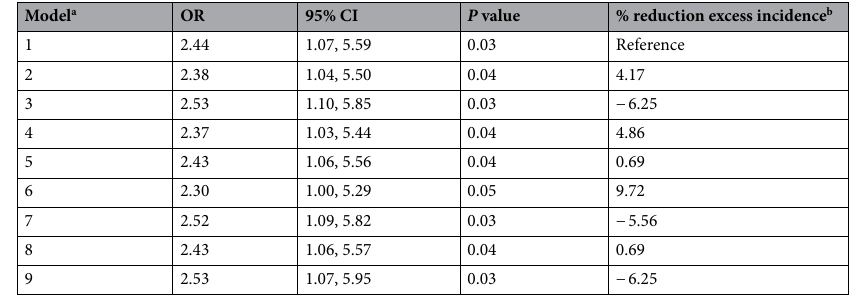
Table 3. Effect of potential explanatory factors on the excess incidence of MetS in participants with depressive symptoms at baseline compared with the non-depressive counterparts group. MetS metabolic syndrome, OR Odds ratio, CI confidence interval. a Adjusted for the following variables: model 1: crude; model 2: education level; model 3: marital status; model 4: smoking; model 5: alcohol consumption; model 6: tea consumption; model 7: physical activity; model 8: heart disease; model 9: education level, marital status, smoking, alcohol consumption, tea consumption, physical activity and heart disease. b % reduction in excess morbidity defined by the formula: (R a −R b )/(R a −1) × 100, where R a is the OR of onset of MetS in participants with depressive symptoms at baseline compared with the non-depressive counterparts group adjusted in model 1 (crude model, reference) and R b is the OR after additional adjustment for the variables in models 2 to 9.